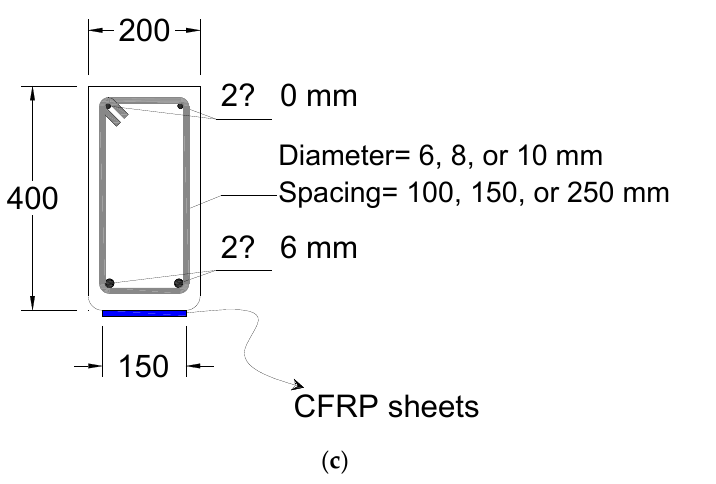
Figure 2. Details of test beams: ( a ) Beams of Series 1; ( b ) Beams of Series 2; ( c ) Cross ‐ section. (All dimensions in mm) Table 1. Test beams.